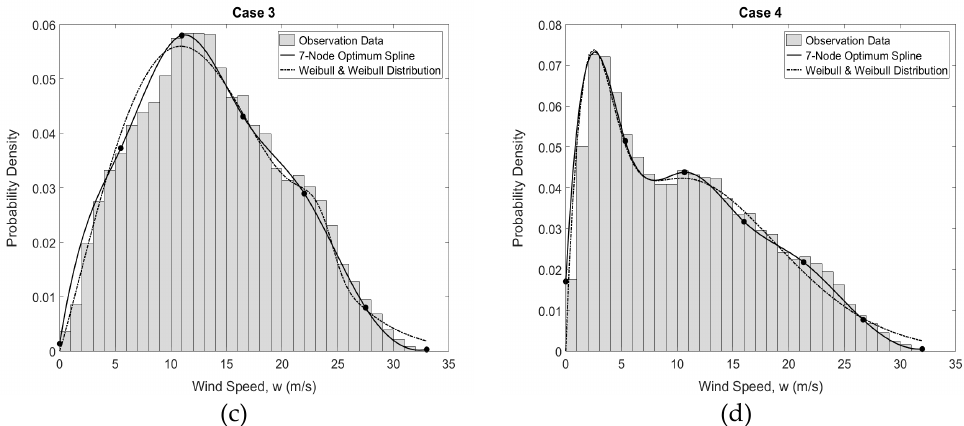
Figure 4. Comparison of the splin- based and Weibull and Weibull fits with the observed data. ( a ) Multimodal distribution 1; ( b ) Multimodal distribution 2; ( c ) Unimodal distribution; ( d ) Multimodal distribution 3.